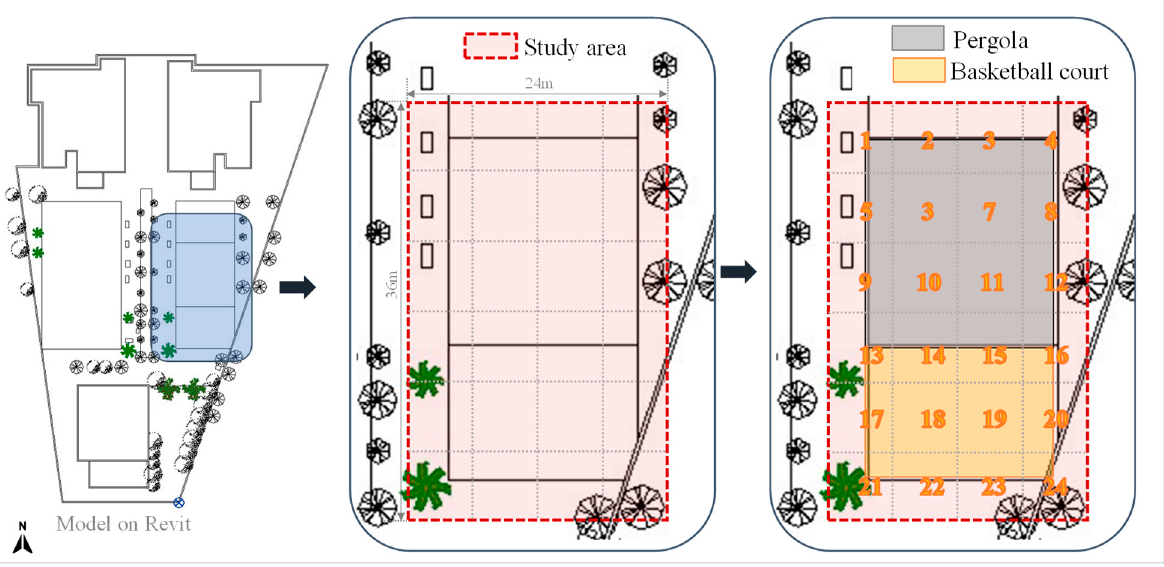
Figure 12. Study area and mesh (model on Revit).